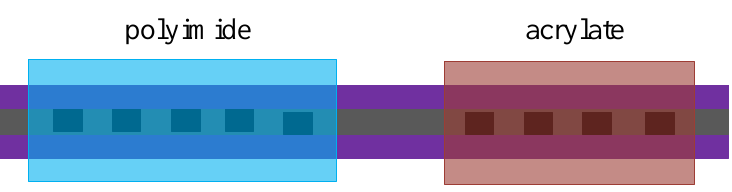
Figure 14. The FBG sensor coated with polyimide and acrylate [77].